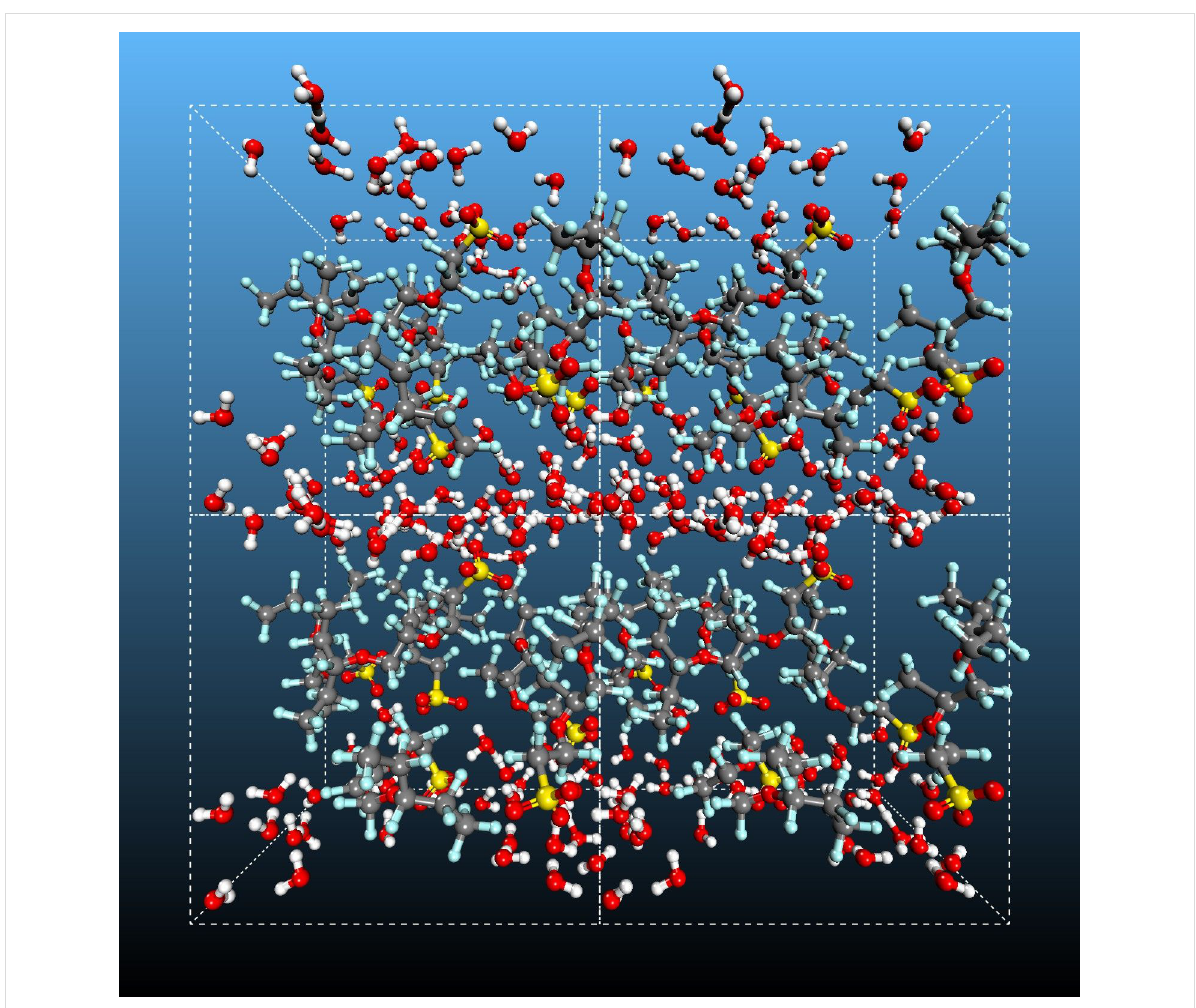
Figure 11: Snapshot of the water-containing Nafion structure obtained after the 200 ps QMD simulation at 298 K and λ = 10. The simulation box is replicated two times along the X- and Z-directions. For clarity, some of the equivalent atoms (not all) across the periodic boundaries are also depicted. Oxygen is shown in red, carbon in gray, fluorine in light blue, hydrogen in white, and sulfur in